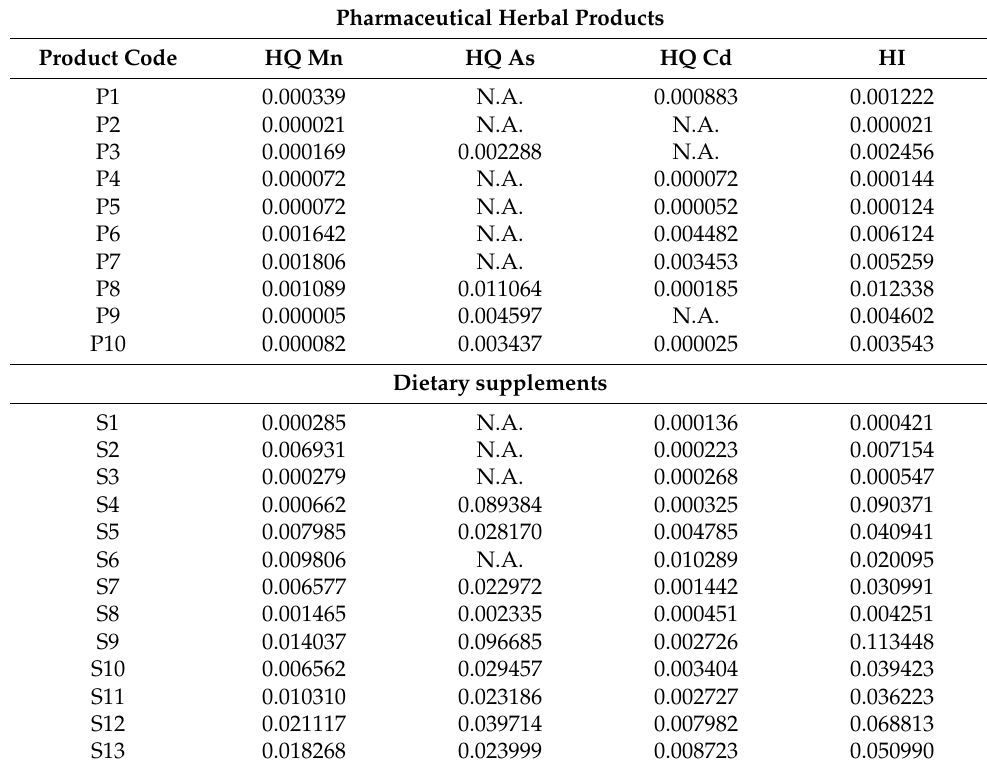
Table 5. Hazard quotient and hazard index estimation of different metals in pharmaceutical herbal products, dietary supplements, and traditional herbal remedies containing Ginkgo biloba